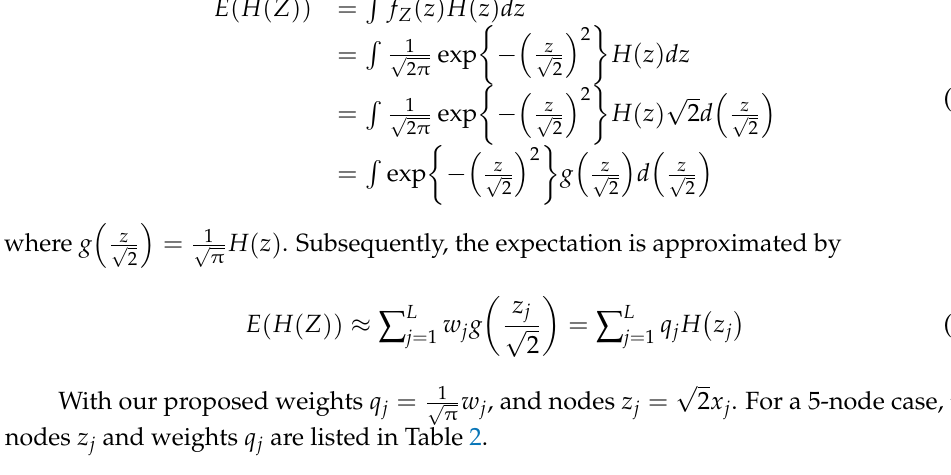
Table 2. Weights and nodes of the five order Gaussian quadrature rule ( L = 5).